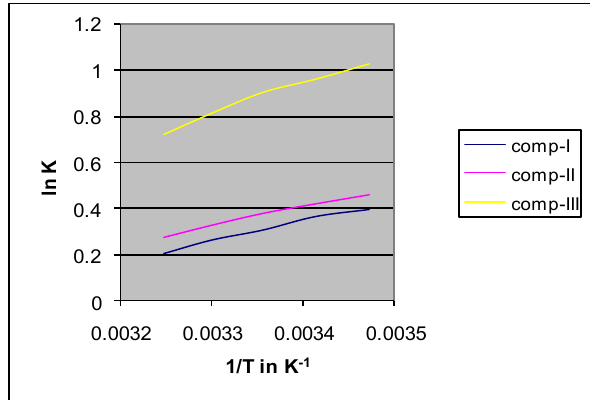
Figure 3: Plot of ln K vs. 1/T of Compound I, II and